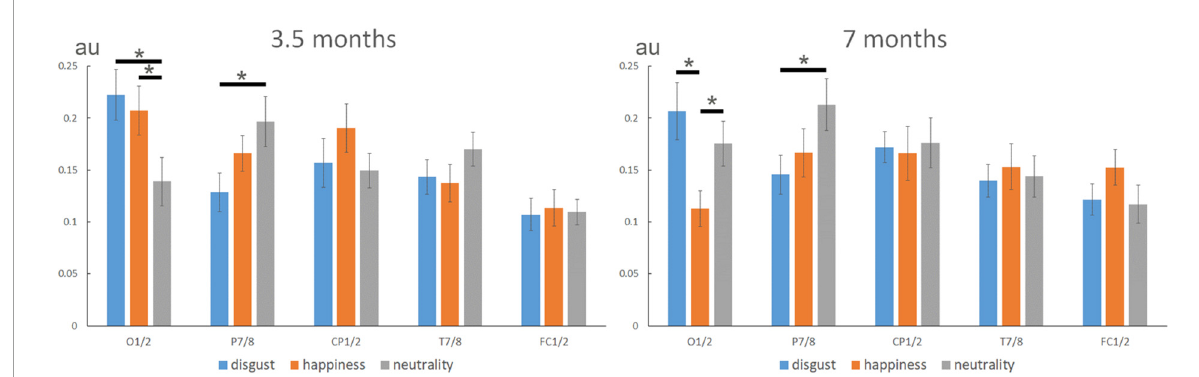
FIGURE3 Expression-change response (normalized noise-corrected amplitudes, in arbitrary units) according to expressions over different sites (O1/2, P7/8, CP1/2, T7/8, and FC1/2) at 3.5 and 7 months. In 3.5-month-olds, the analysis revealed a similar topography for the two emotional expressions (i.e., disgust and happiness) that differed from neutrality with a lower contribution of O1/2 and a higher contribution of P7/8 for neutrality. In 7-month-olds, the topography of the expression-change response discriminated between disgust, neutrality, and happiness, with a lower contribution of O1/2 to the response to happiness compared to both disgust and neutrality. As for the 3.5-month-olds, P7/8 channels contributed more to the discrimination of neutrality than disgust. Note also the tendency for a higher contribution of FC1/2 to happiness, that was driven by a significant response over FC2 for happiness (see previous analyses). “*” indicated significant differences (p <